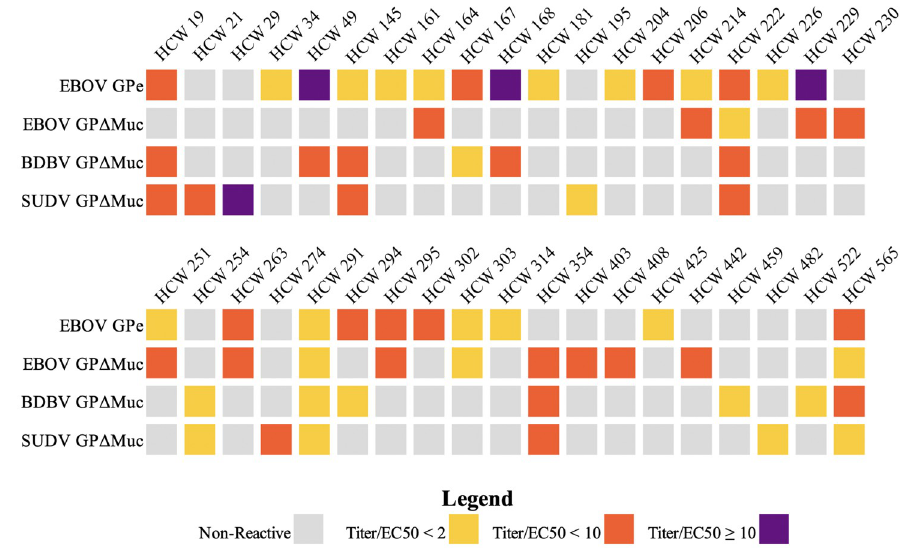
Fig 2. Patient Seroreactivity by Antigen. The breadth of participant seroreactivity against ebolaviruses in the 36 reactive samples is illustrated. None of these individuals reported exposure to confirmed or probable EVD cases. The samples were characterized by the interpolation of the IgG concentration (Titer) divided by the EC 50 of Adimab-15878 for the plate. They were further classified into separate groups by the level of the Titer/EC 50 ratio: 1 < 2 for Weak Reactivity, 2 � 10 for Moderate Reactivity, and 10+ for Strong Reactivity. Four samples were strongly reactive: 3 EBOV GPe (Titer/EC 50 : 86 (HCW 49), 16 (HCW 168), 16 (HCW 229)) and 1 SUDV GP Δ Muc (Titer/EC 50 : 30 (HCW